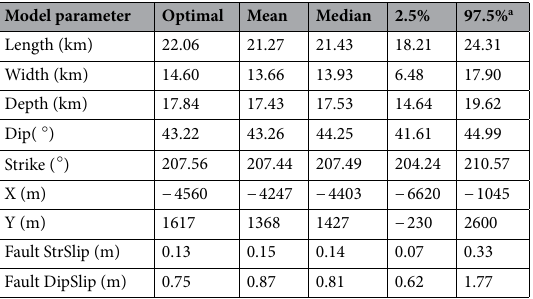
Table 1. Geometric parameters of planar faults. a We obtained maximum posteriori probability solutions of 2.5% and 97.5% from the posterior probability density functions of the fault